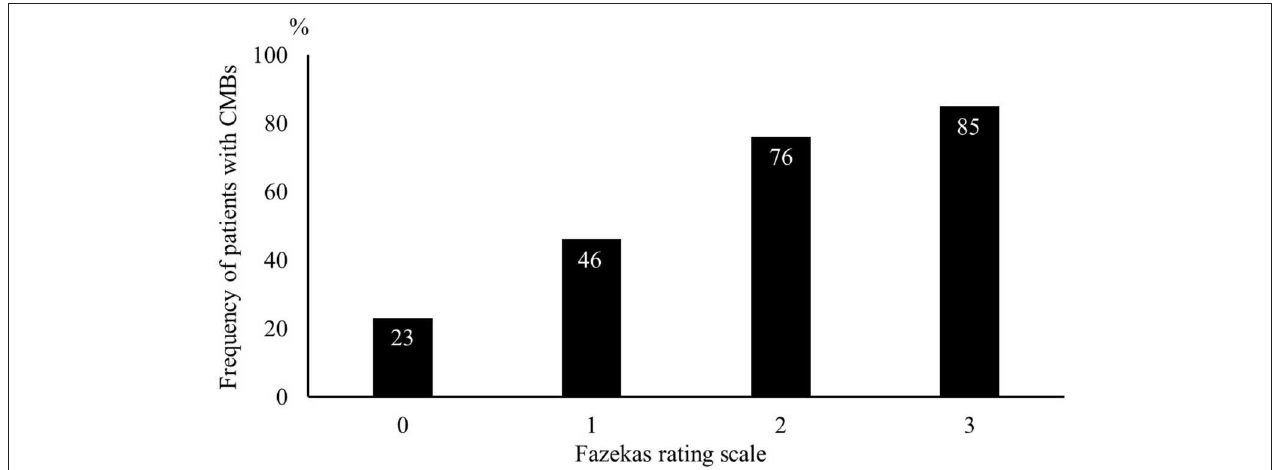
FIGURE 2 | Frequency of patients with cerebral microbleeds using the Fazekas scale. The likelihood of cerebral microbleeds being present increased gradually with higher Fazekas scale scores.